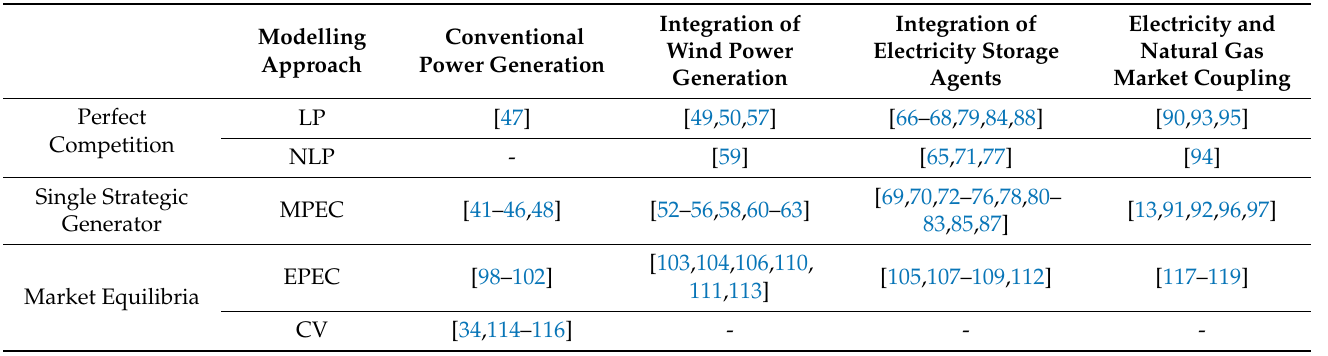
Table 1. Classification of research contributions based on their modelling approaches and market characteristics.